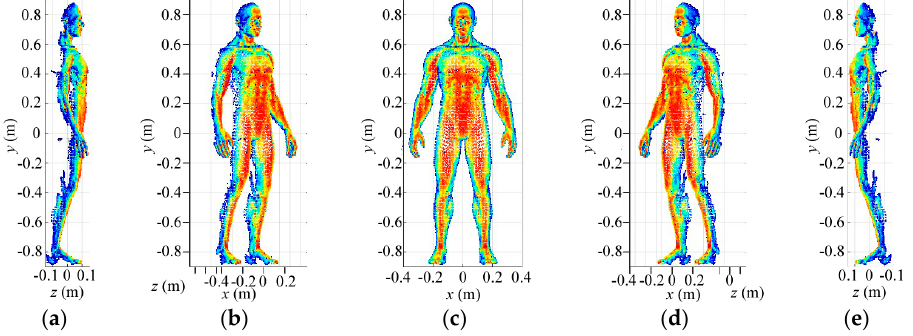
Figure 12. Reconstruction results at medium-resolution level in different perspectives: ( a ) the left side; ( b ) the left front side; ( c ) the front; ( d ) the right front side; and ( e ) the right side.